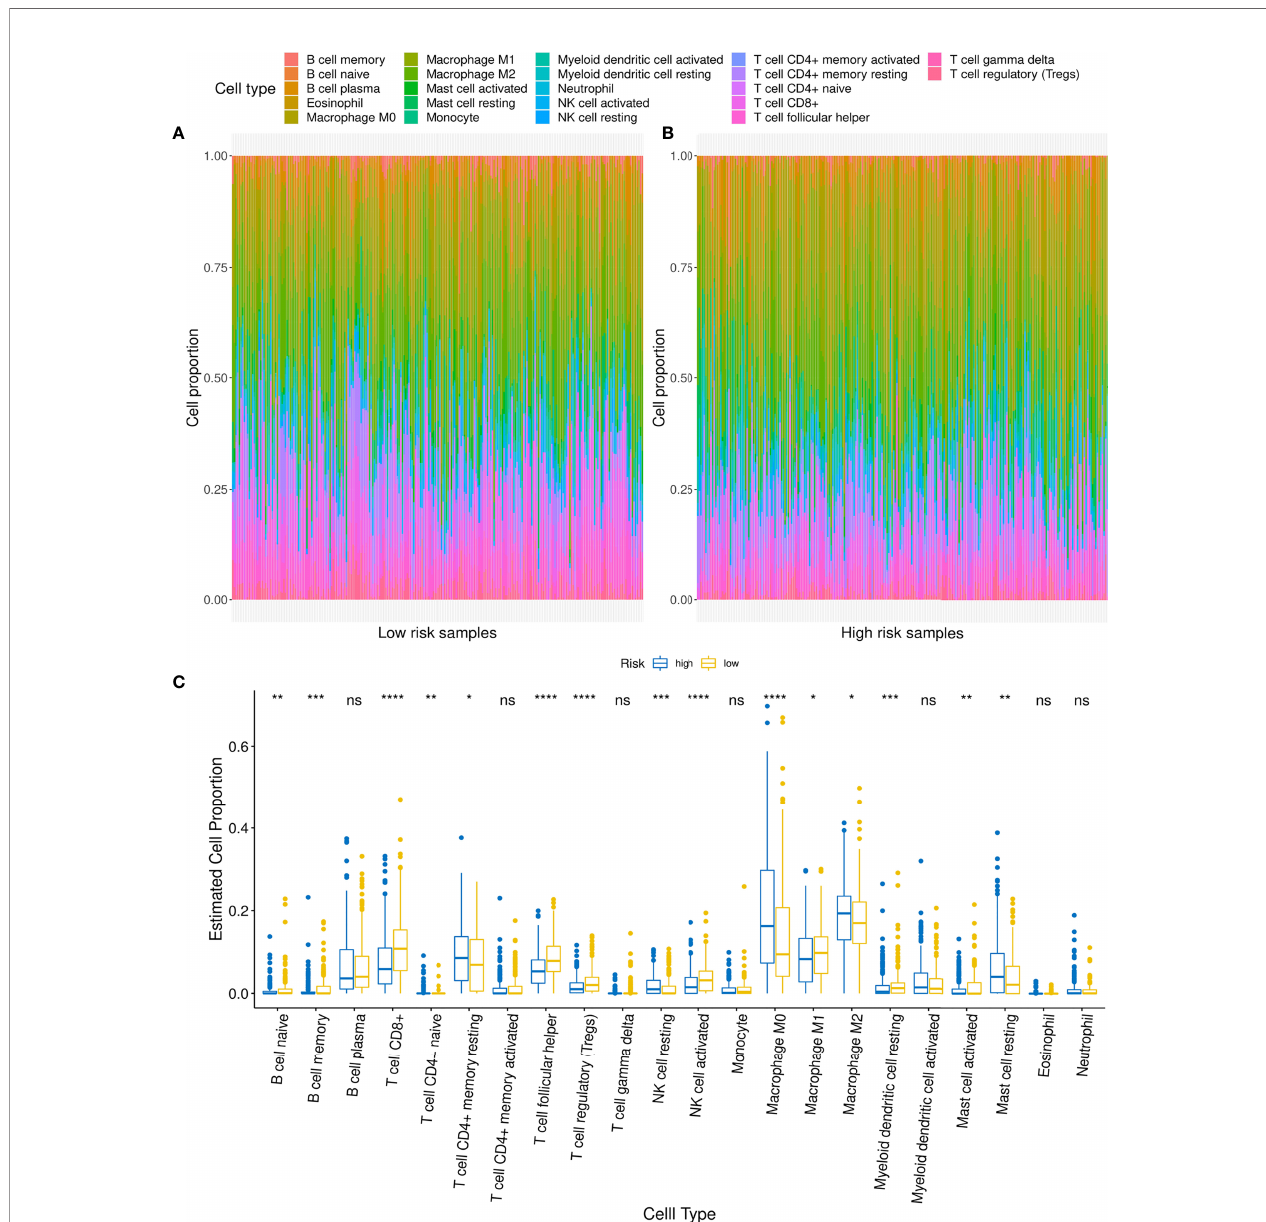
FIGURE 8 | Relationship between low- and high-risk groups and immune cell in fi ltration. (A, B) Comparison of distribution of immune cell in fi ltration types in low- and high-risk groups. (C) Difference in in fi ltration of various immune cells between low- and high-risk groups. For t-test: ns, p ≥ 0.05; * p < 0.05; ** p < 0.01; *** p < 0.001; **** p <